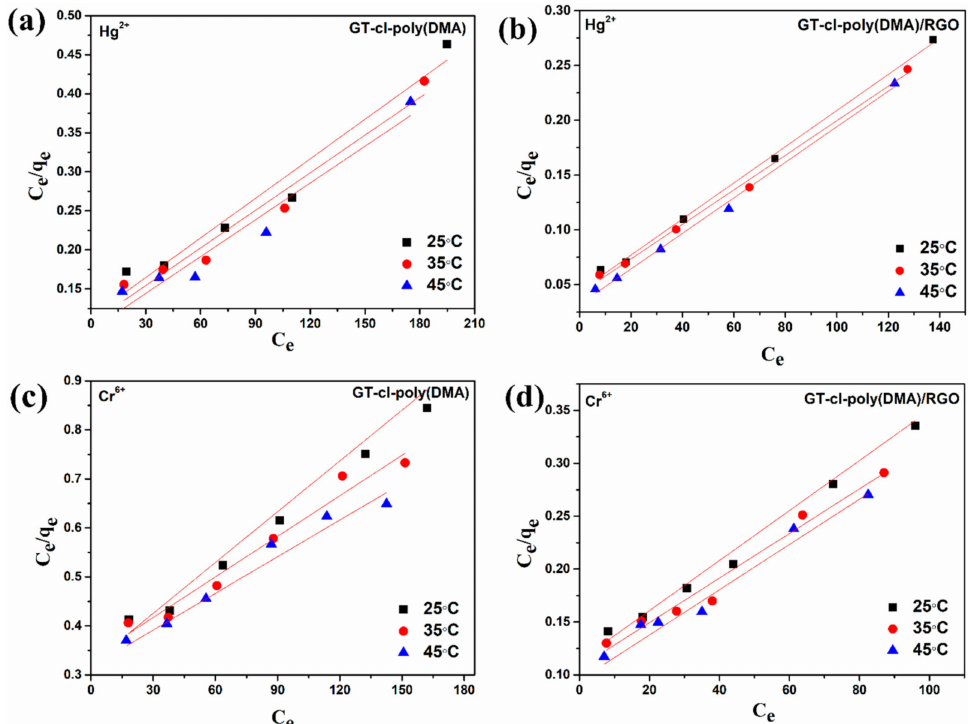
Figure 8. Langmuir isotherm model for Hg 2 + adsorption by ( a ) gum tragacanth-cl- N,N - dimethylacrylamide (GT-cl-poly(DMA)) hydrogel ( b ) reduced graphene oxide incorporated gum tragacanth-cl- N,N -dimethylacrylamide (GT-cl-poly(DMA) / RGO) hydrogel composite, Langmuir isotherm model for Cr 6 + adsorption by ( c ) gum tragacanth-cl- N,N -dimethylacrylamide (GT-cl-poly(DMA)) hydrogel ( d ) reduced graphene oxide incorporated gum tragacanth-cl- N,N - dimethylacrylamide (GT-cl-poly(DMA) / RGO) hydrogel composite. (Experimental conditions for Hg 2 + : adsorbent dose—0.035 g, pH—5.5, metal ion concentration—20–300 ppm, rpm = 200 and for Cr 6 + : adsorbent dose—0.045 g, pH—3.5, metal ion concentration—20–500 ppm, rpm =